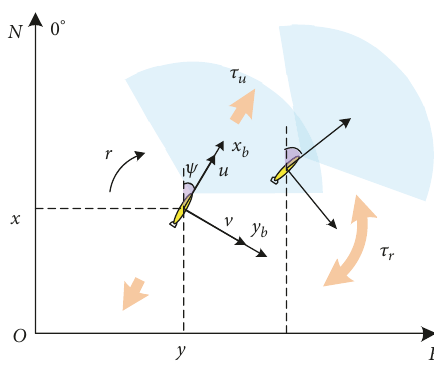
Figure 1: Global and local coordinate